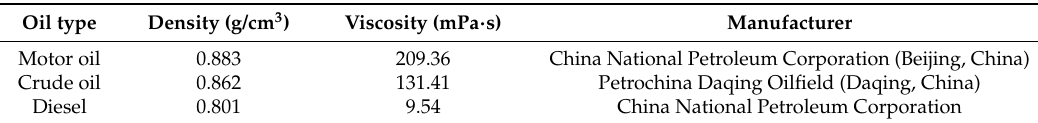
Table 2. Properties of tested oil.